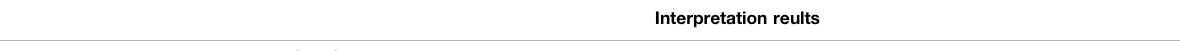
TABLE 2 | Fitting interpretation results for production decline of Well M2.